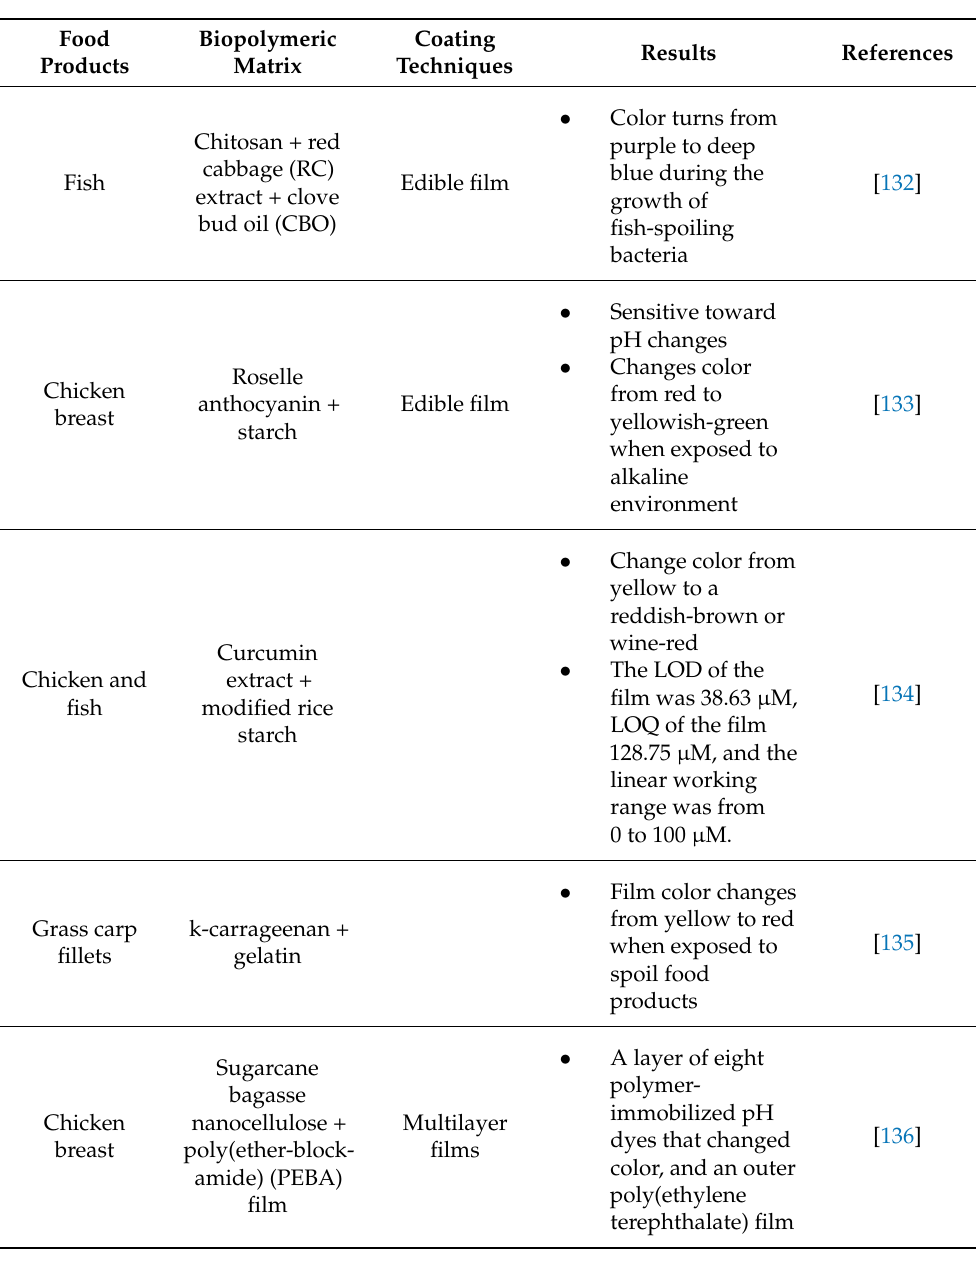
Table 3. Application of smart packaging in food